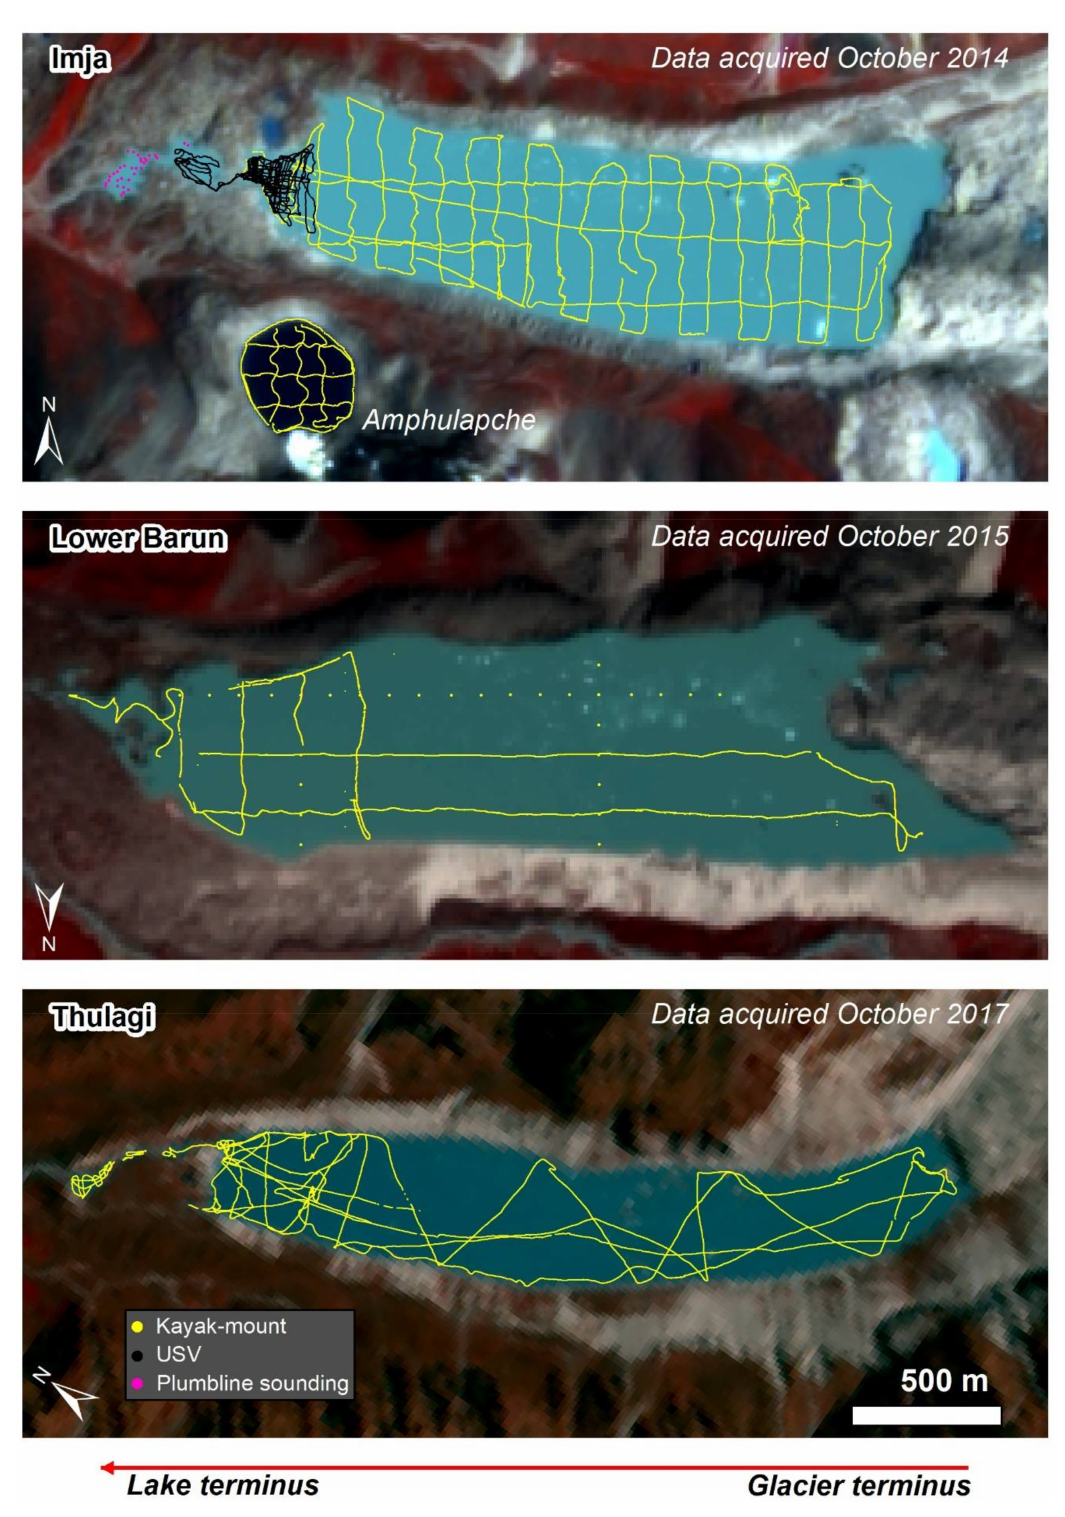
Figure 2. Vessel tracks collecting bathymetric data at each of these lake locations. Yellow dots in the middle figure (Lower Barun Lake) shows points where depth and location data were collected